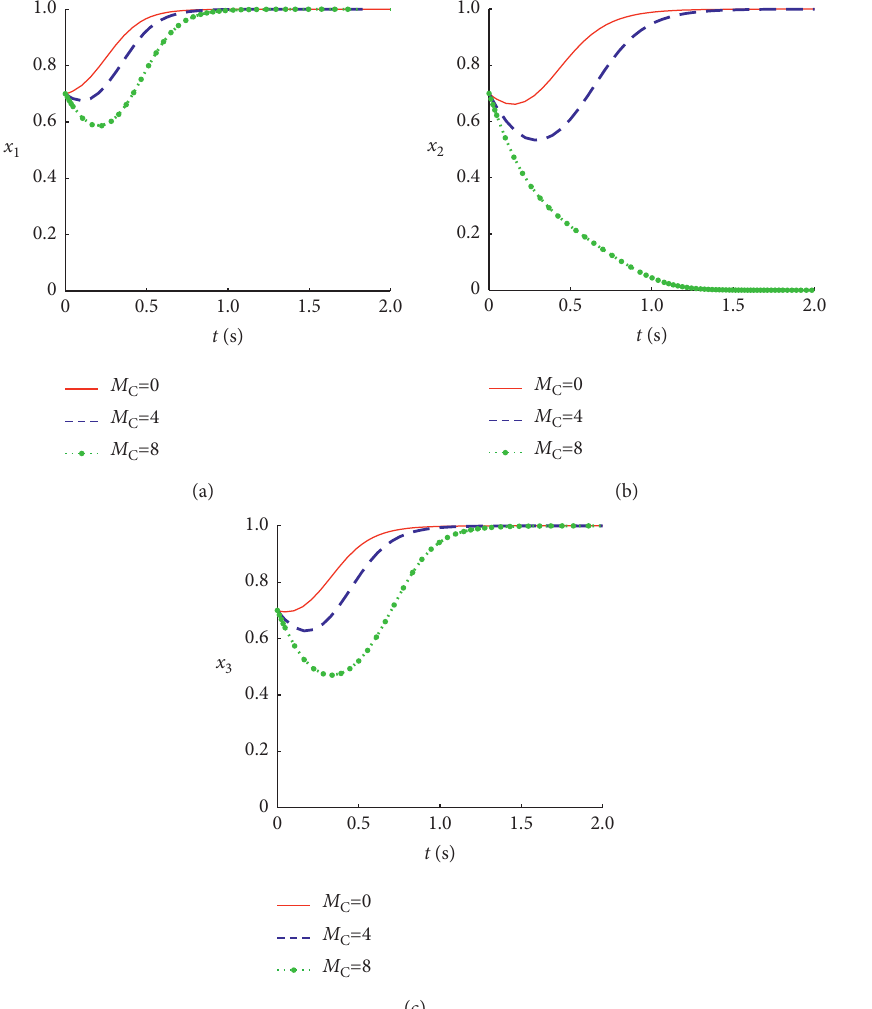
Figure 2: Evolutionary paths of the proportion of lane changing strategy under different safety losses. (a) Model 1; (b) Model 2; (c) Model